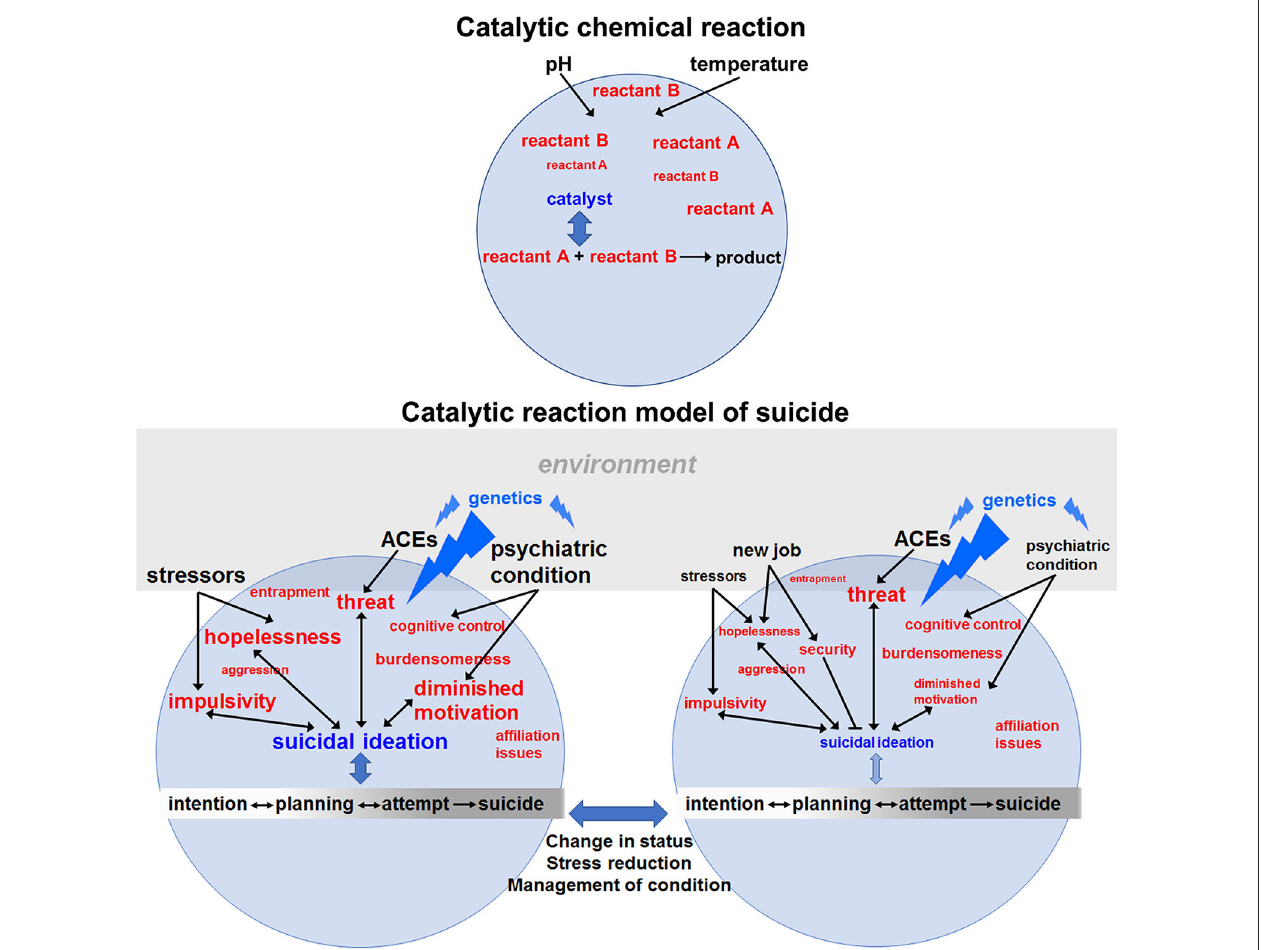
FIGURE 1 | Catalytic reaction model of suicide. In a chemical reaction (upper panel), reactants may combine slowly in the absence of a catalyst, which interacts with both reactants, lowers the energy barrier to the chemical reaction and catalyzes formation of product. Conditions and concentrations of reactants along with the activity of the catalyst determine the rate of the reaction. By analogy, in the lower left panel, various reactants (in red font) combine to determine the catalytic activity of suicidal ideation, which then lowers the “energy” barrier for suicidal behaviors (intention, planning, attempts and completion). The lack of arrows between a pictured reactant and suicidal ideation indicates that at this particular time those factors are manageable and do not contribute to the ongoing suicide reaction. The rate of the suicidal reaction is also determined by environmental conditions (black font) such as stressors or the presence of a psychiatric condition and how well it is being managed. The font size of the reactants and conditions reflects their “concentrations” or “energy” – determined by the intensity, frequency and duration of their effects. Genetic variation (blue font) affects the reaction at several levels by: (1) specifying vulnerability to psychiatric disorders, (2) determining resiliency or acuity in the face of adverse childhood experiences (ACEs) and (3) affecting the emergence and intensity of hopelessness, impulsivity, diminished motivation, etc. in response to changes in the environment. Genetic variants will also affect how a person responds to stressors. As discussed in the next section, genes (e.g., those involved in insulin signaling) affect motivation states, threat assessment (e.g., neuropeptide Y) and impulsivity. In this way, a genetic risk variant can act as a catalyst by lowering the “energy” barrier for expressing various reactants that give rise to STBs. The environment plays a role by affecting motivation (e.g., through reward